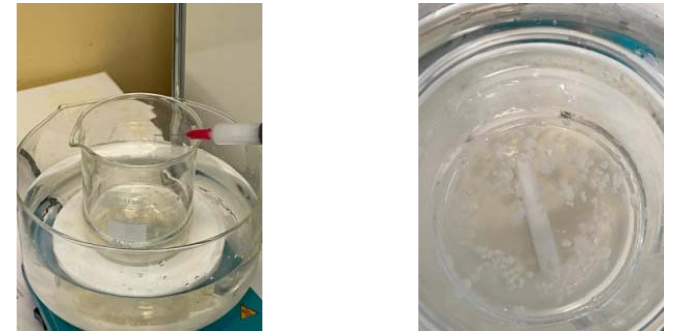
Figure 2. Performing the microencapsulation of essential oils in a sodium alginate shell. A flow chart of the procedure used to develop samples E1–E8 is presented in Figure 3.